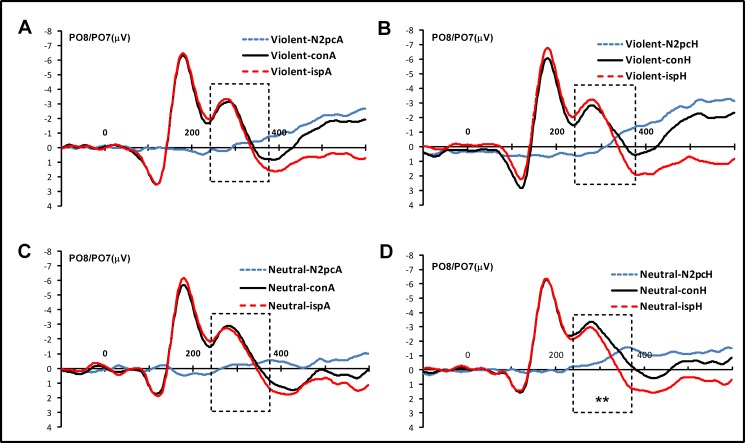
The N2pc for task B.(A) It represent the grand averages of N2pc in the violent video game group in response to angry faces. (B) It represent the grand averages of N2pc in the violent video game group in response to happy faces. (C) It represent the grand averages of N2pc in the neutral video game group in response to angry faces. (D) It represent the grand averages of N2pc in the neutral video game group in response to happy faces. *p < .05, **p < .01.